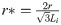
Assessment of finite size effects in simulations of ideal, non-interacting chains.(a) Pair distribution functions computed in terms of the spatial separation between chain units. The distributions are maximal at r = L/2, where L is the size of the simulation cell for a given system. Note that L increases as the number of polymers in the system increases. With the exception of the smaller systems, the ideal chains show self-similar behavior for different system sizes. (b) The data plotted in panel (a) are re-plotted in terms of the scaled variable r*=2r3Li where Li is the size of the simulation cell for boxes with i molecules.